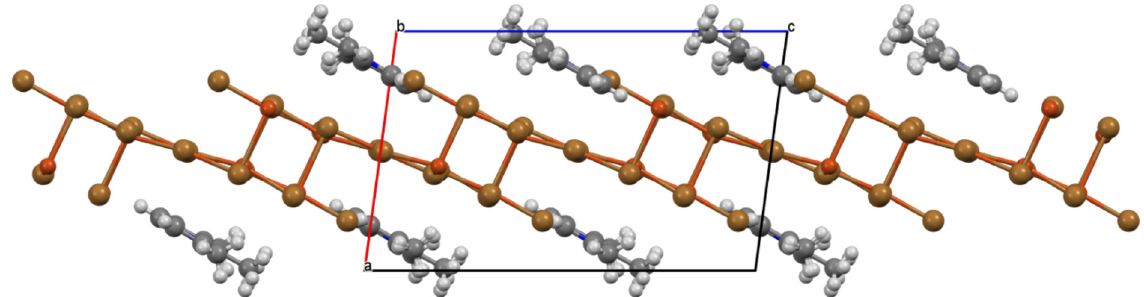
Figure 5. Ball-and-stick unit cell packing diagram for (1,2,3-trimethylpyridinium) 2 Cu 5 Br 12 viewed parallel to b with a almost vertical and c horizontal. Atoms are drawn as spheres of arbitrary radii and H-atoms are included to identify placement of methyl groups. The mixed organic cation/complex anion sheets coincident with (302) are edge-on in this diagram.